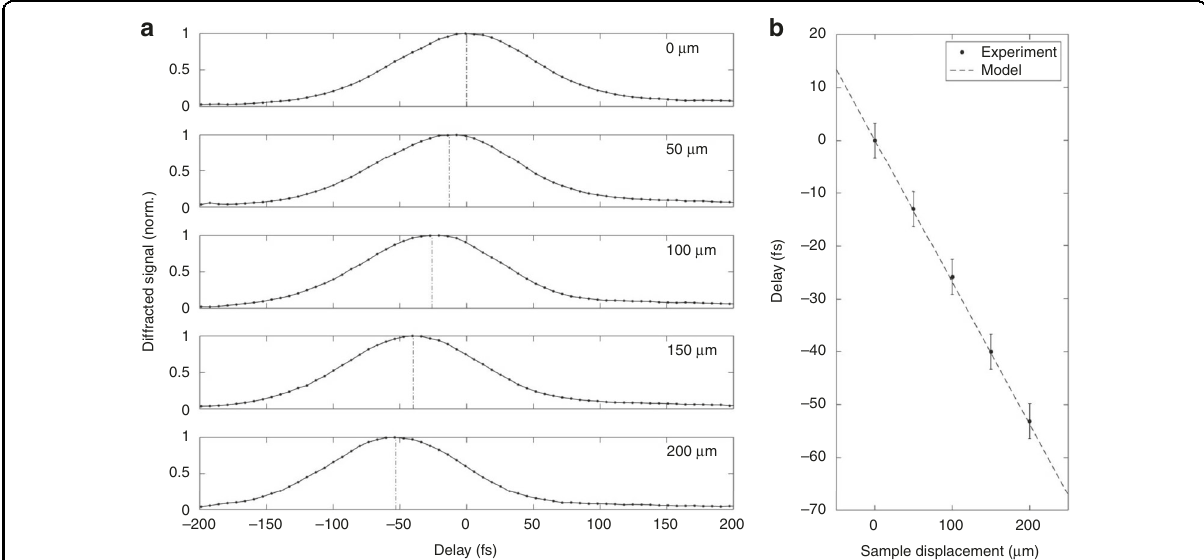
Fig. 3 Pump-probe delay change by sample translation. a Evolution of the TG signal as a function of sample position in sapphire (from 0 to 200 μ m). b Barycenter of TG signal as a function of sample displacement; experimental data are in excellent agreement with the model of Eq. (2). The parameters are provided in the “ Methods ” section. The error bar is due to the determination accuracy of the barycenter, linked to the positioning accuracy of the delay